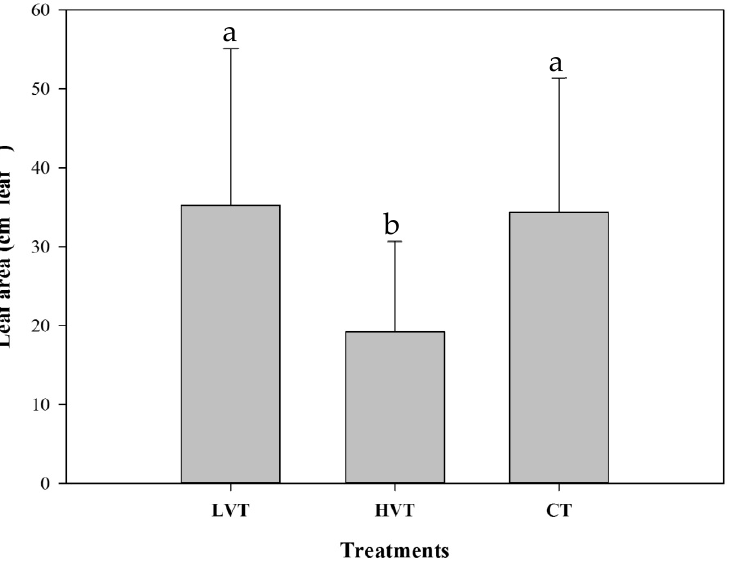
Figure 9. The average leaf area for strawberries for each treatment. Means followed by the same letter are not significantly different ( p < 0.05, Scheffé test). LVT is the low-temperature oscillation pattern, HVT is the high-temperature oscillation pattern, and CT is the fixed temperature regime. A comparison of the average leaf area is shown in Figure 9. The analysis of variance results are significantly different (F(2, 91) = 10.369, p < 0.001). For multiple comparisons, the Scheff é test shows there is a significant difference between the high oscillation temperature and the other two groups at the 95% confidence level. The order of the average value is low temperature oscillation (35.286 cm 2 ) > constant temperature (34.370 cm 2 ) > high oscillation temperature (19.193 cm 2 The results of the analysis of variance for comparing the number of leaves show no significant difference (F(2, 21) = 2.811, p = 0.083). The order of the average value is low oscillation temperature (7.875 pieces) > constant temperature (7 pieces) > high oscillation temperature (6.125 pieces). However, there is no significant difference in the results. A comparison of average leaf weights is shown in Figure 10. The results of the anal- ysis of variance show that there is a significant difference (F(2, 73) = 8.103, p < 0.001).